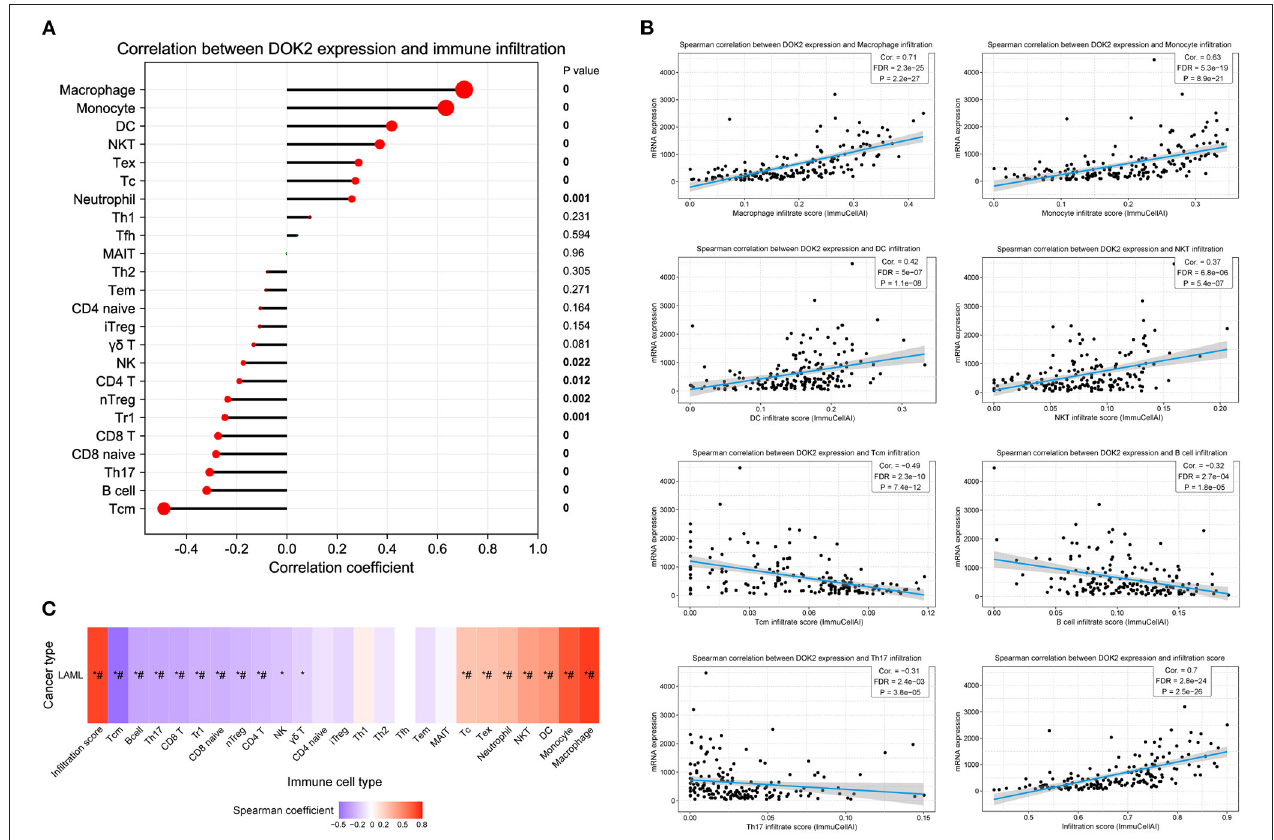
FIGURE 8 | Association between DOK2 expression and immune cell abundance according to GSCA. (A) The correlation between DOK2 and immune cell infiltration using ssGSEA. (B) Spearman correlations of DOK2 expression with significant immune infiltration types. (C) The association between immune cell infiltrates and GSVA score in AML. * P < 0.05; # FDR <